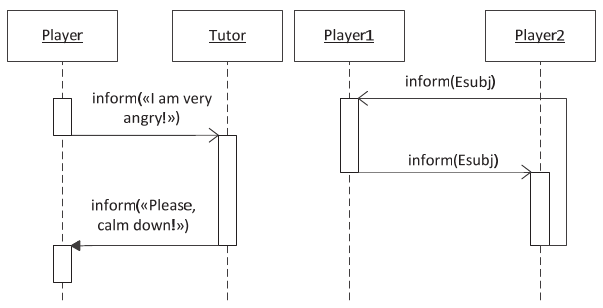
Fig. 3. On the left – interactions between a Player and a Tutor Agent; on the right – interaction between two Player Agents. In the deployment step , it was important to decide on parameters for student personalities, which were chosen as an average based on psychology research; to implement various patterns, there were two types of social links: cooperative and